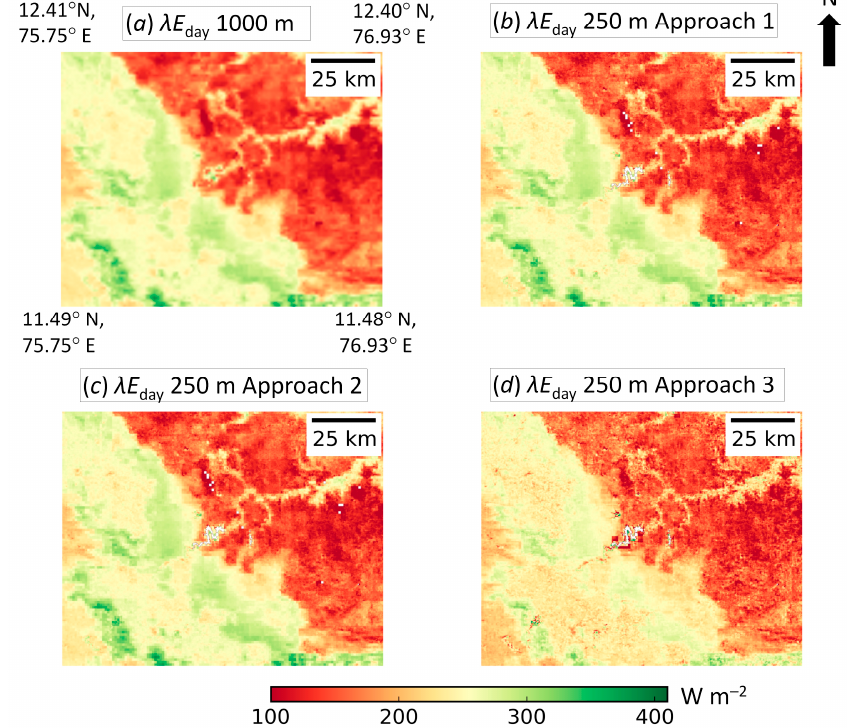
Figure 6. Spatial pattern of λ E day observed on 14 November 2012 over Site 5. ( a ) λ E day at 1000 m resolution and ( b – d ) λ E day disaggregated to 250 m using approaches 1, 2 and 3 respectively.